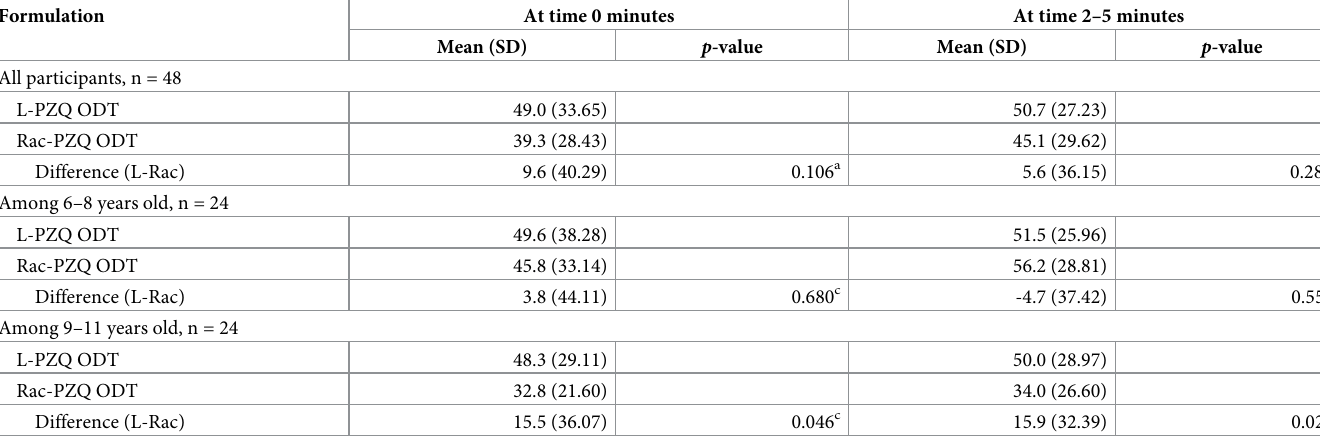
Primary outcome The overall mean (SD) VAS scores in millimeters (both age groups and genders combined) t = 0 for L-PZQ ODT and Rac-PZQ ODT without water were 49.0 (33.7) and 39.3 (28.4), respec- tively. The mean difference (SD) in VAS scores between the two formulations was not sig- t = 0 nificant (9.6 [40.3]; p = 0.106) (Table 2). Secondary outcomes L-PZQ ODT and Rac-PZQ ODT without water. The overall mean (SD) VAS t = 2–5 scores for L-PZQ ODT and Rac-PZQ ODT without water were 50.7 (27.2) and 45.1 (29.6), respectively. The overall mean (SD) difference in VAS scores between the two formula- t = 2–5 tions was not significant (5.6 [36.1]; p = 0.284). However, there was a significant interaction between the formulation and age group at this time point (interaction p = 0.0499). The mean VAS scores for L-PZQ ODT without water did not differ from scores for Rac-PZQ ODT with- out water in younger children (6–8 years old). Among older children (9–11 years old), VAS scores for L-PZQ ODT without water compared with Rac-PZQ ODT without water were Table 2. VAS scores (mm) for L-PZQ ODT and Rac-PZQ ODT without water (Day 1) at time points 0 and 2–5 minutes and stratified by age category.